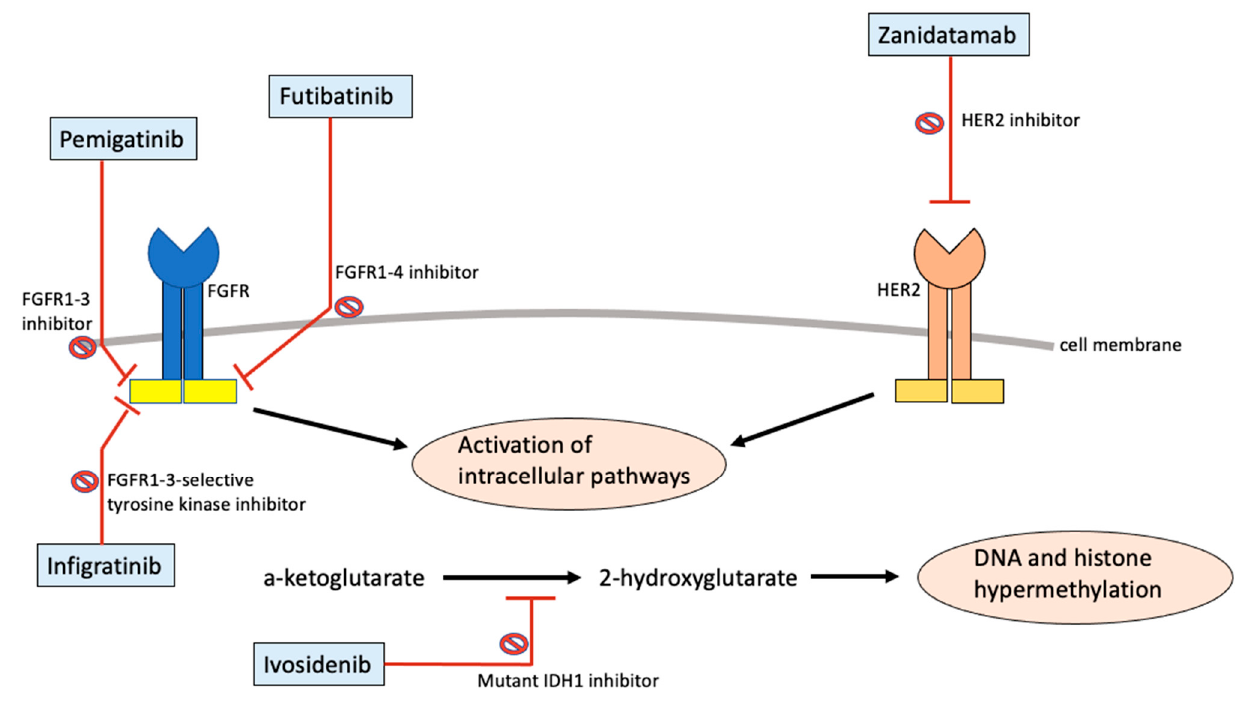
Figure 2. Mechanism of action of targeted therapies with FDA approval or breakthrough therapy designation.